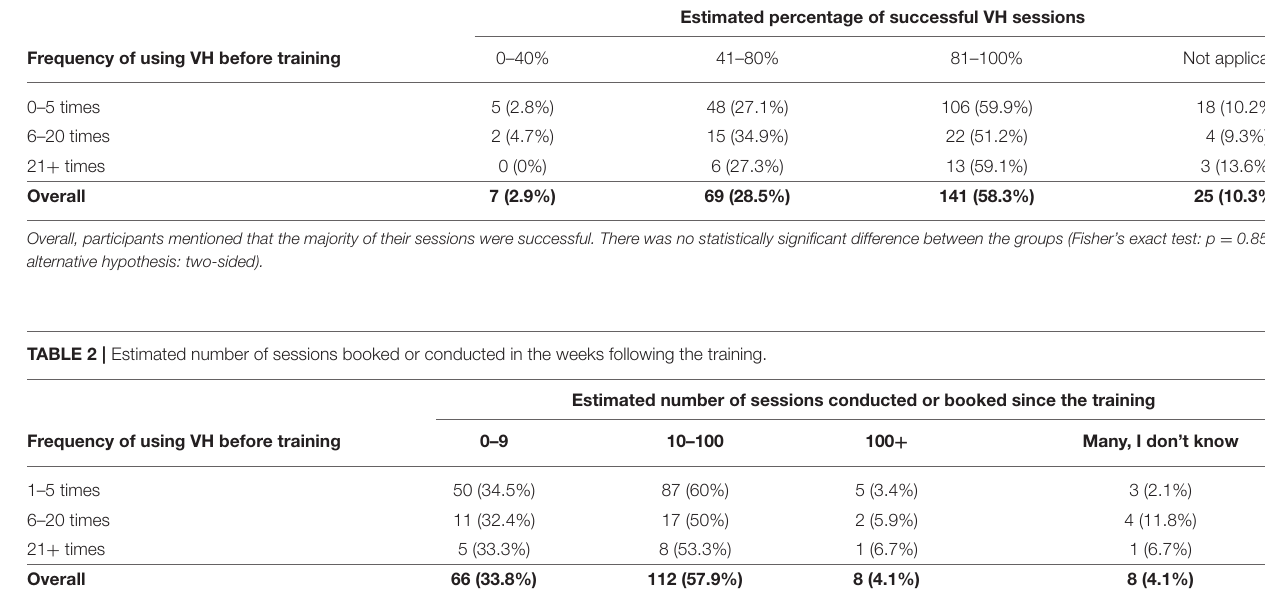
TABLE 1 | Estimated percentage of successful VH sessions for participants with different previous exposures to VH.